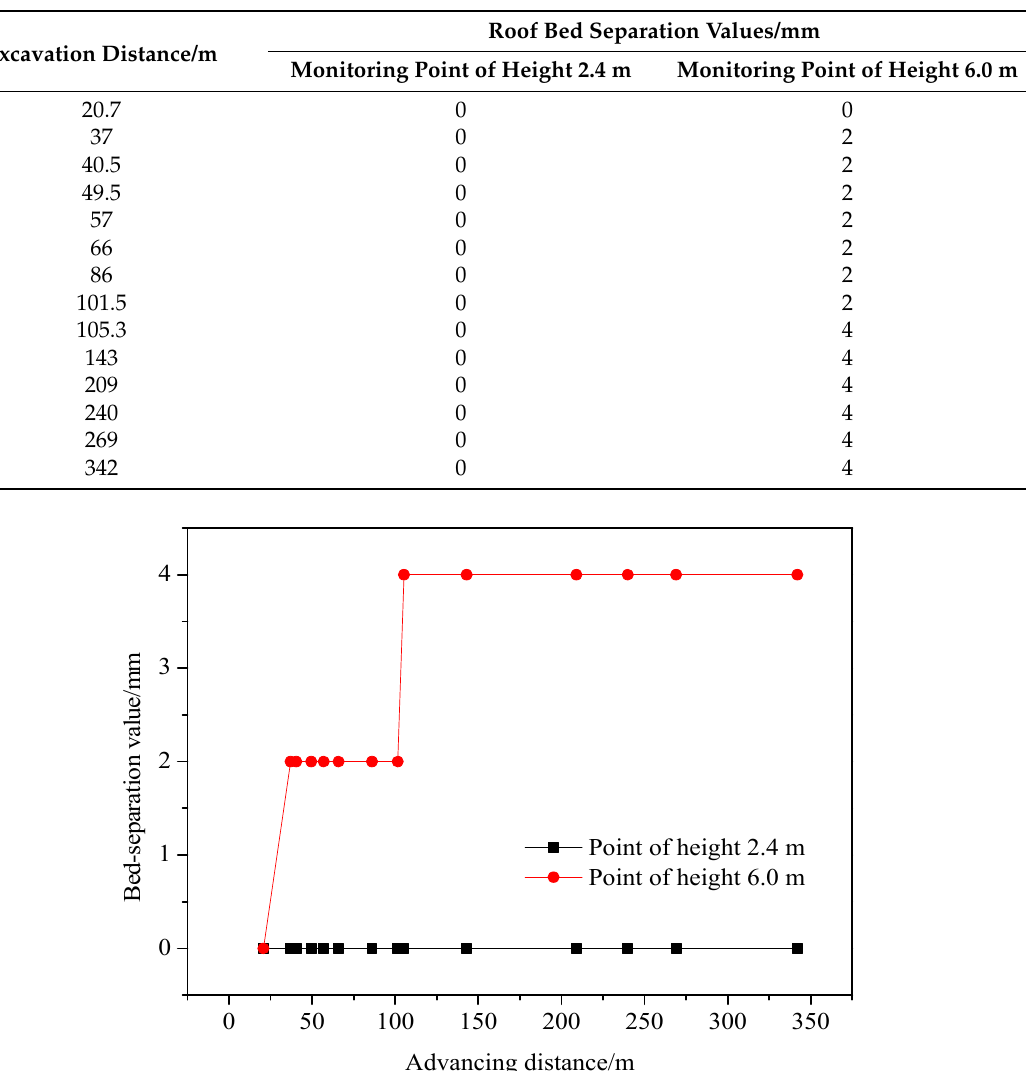
Figure 21. Rock failure with different depths depicted by electronic drilling peep instrument.